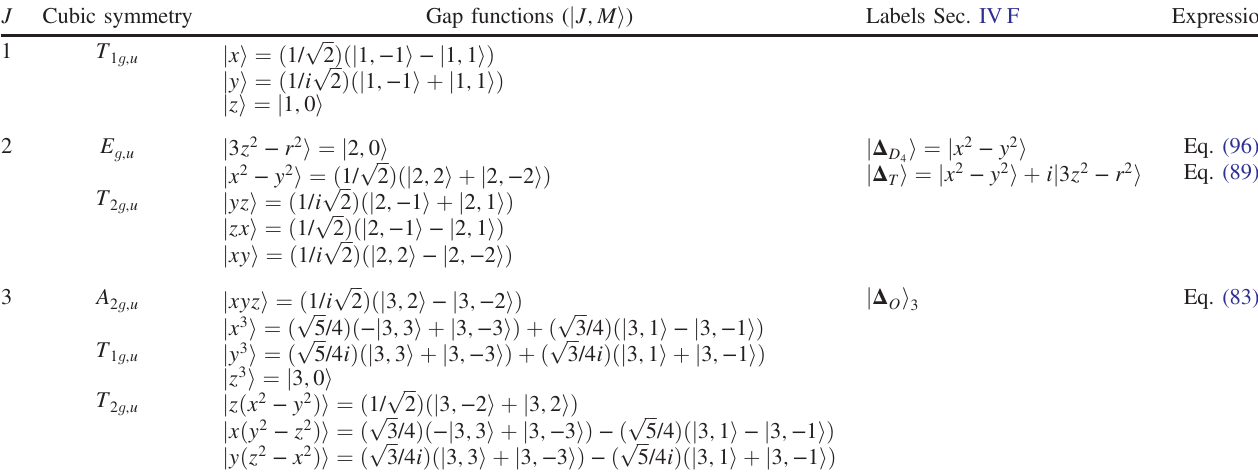
TABLE VII. Splitting of pairing channels in cubic systems. In the presence of cubic crystal anisotropy, the isotropic pairing channels labeled by angular momentum J are split into cubic pairing channels labeled by cubic representations, as explained in Sec. II B. Here, we list the splitting of the isotropic pairing components given in Eq. (7) into pairing functions transforming as partners of the cubic representations; this is shown in the third column, using the notation of Eq. (13). We list the splitting of angular momentum channels J ¼ 1 , 2, 3, 4. Note that some cubic representations appear multiple times; the corresponding pairing functions are “ degenerate ” in cubic symmetry. Note further that the parity g , u depends on the quantum numbers ð L; S Þ . A number of pairing states that can arise in cubic systems (and thus necessarily have discrete symmetry; see Sec. IV G) are discussed in Sec. IV F; these are listed in the fourth column. Column five refers to the specific